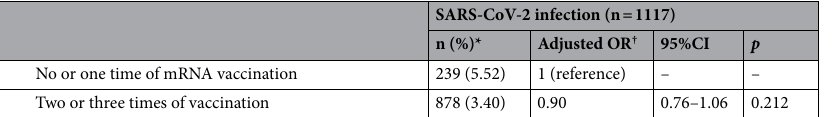
Table 2. Factors associated with SARS-CoV-2 infection among all participants (n = 30,130). *Percentages of infected individuals in each category. † Estimated using multivariable logistic regression modeling with adjustment for all listed variables. Values of p < 0.05 were considered statistically significant and corresponding adjusted ORs are shown in bold. ‡ 21 prefectures that had been declared the State of Emergency more than once. § Under 18 years old. ¶ 12 diseases listed in Table 1. || Percentage of 12 infection prevention behaviors being performed. SARS-CoV-2 severe acute respiratory syndrome coronavirus 2, n number (weighted by inverse probability weighting), OR odds ratio, CI confidence interval, HTPs heated tobacco products, METs metabolic equivalents, mRNA messenger ribonucleic acid.